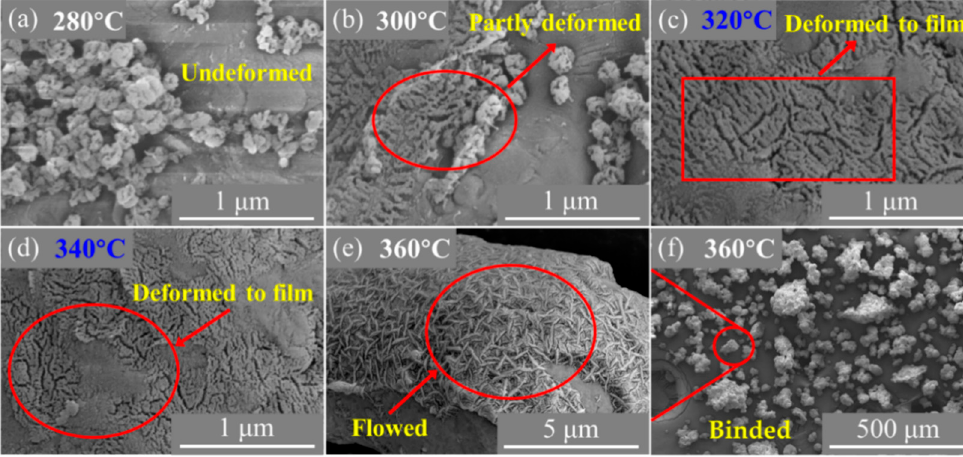
Figure 5. SEM images of Al/PTFE composites heated at different temperatures: ( a ) 280 °C; ( b ) 300 °C; ( c ) 320 °C; ( d ) 340 °C; ( e , f ) 360 °C. t h = 4 h.